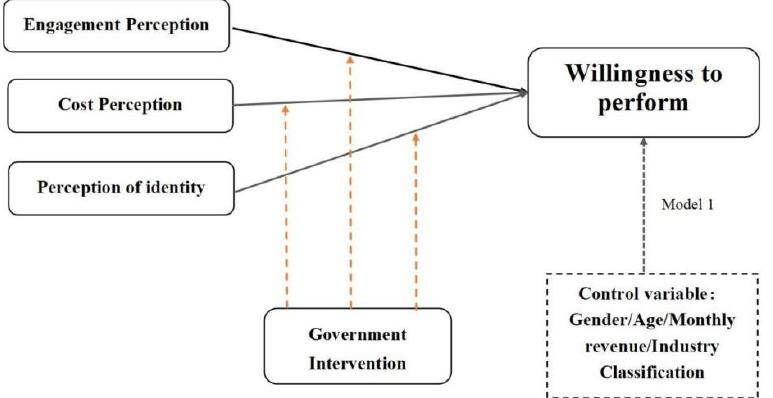
Figure 2. The perception model of industrial ecological transformation willingness for zero waste cities.